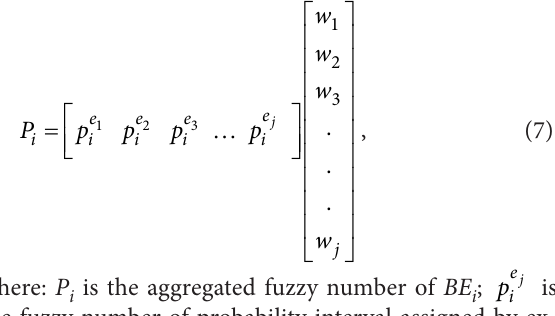
Table 3. Determining the probability of different basic events and the importance analysis using fuzzy importance measures FactorCode